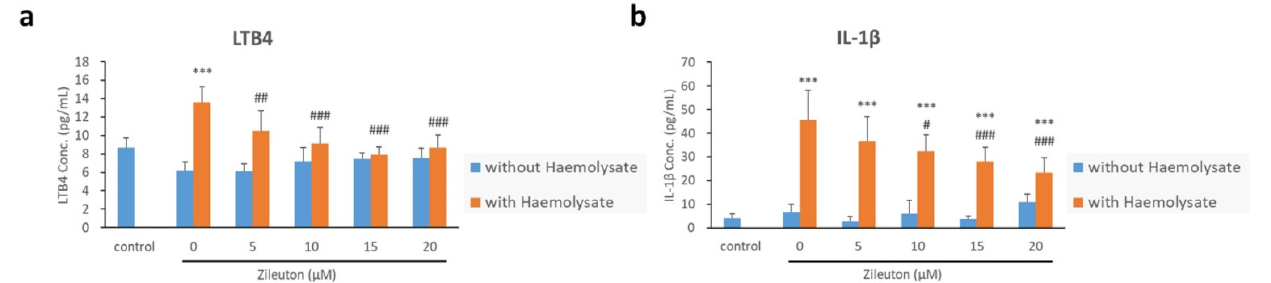
Figure 5. ELISA results for LTB4, IL-1 β , TNF- α , IL-10, and TGF- β from the cell culture superna- tant. ( a ) ELISA results for LTB4. The concentration of LTB4 in the haemolysate + vehicle group was higher than that in the control group. Following treatment with 5, 10, 15, and 20 μΜ of zileu- ton, the haemolysate-exposed BV-2 cells showed a lower concentration of LTB4 than those treated with the vehicle. There was no significant difference between haemolysate-exposed, zileu- ton-treated BV-2 cells, and BV-2 cells in the control group (*** p < 0.001 compared with control; ## p < 0.01, ### p < 0.001 compared with haemolysate + vehicle group, n = 3). ( b ) ELISA results for IL-1 β . The haemolysate + vehicle group and the haemolysate + zileuton (5, 10, 15, and 20 μΜ ) groups had a higher concentration of IL-1 β than the control group. The haemolysate-exposed BV-2 cells treated with 10, 15, and 20 μΜ of zileuton displayed a lower concentration of IL-1 β than BV-2 cells in the haemolysate + vehicle group (*** p < 0.001 compared with control; # p < 0.05, ### p < 0.001 compared with haemolysate + vehicle group, n = 3). ( c ) ELISA results for TNF- α . The haemolysate-exposed BV-2 cells treated with the vehicle, as well as 5, 10, 15, and 20 μΜ of zileuton, showed elevated concentrations of TNF- α compared with the control group. The haemolysate-exposed BV-2 cells treated with 15 and 20 μΜ of zileuton showed a lower concentration of TNF- α than those treated with the vehicle (*** p < 0.001 compared with control; ### p < 0.001 compared with haemolysate + vehicle group, n = 3). ( d ) ELISA results for IL-10. The haemolysate-exposed BV-2 cells treated with the vehicle, as well as 5, 10, 15, and 20 μΜ of zileuton, had an increased concentration of IL-10 compared with the control group. After being treated with 10, 15, and 20 μΜ of zileuton, haemol- ysate-exposed BV-2 cells showed a higher concentration of IL-10 than those treated with the vehicle (*** p < 0.001 compared with control; # p < 0.05, ## p < 0.01, ### p < 0.001 compared with haemolysate + vehicle group, n = 3). ( e ) ELISA results for TGF- β . The haemolysate-exposed BV-2 cells treated with the vehicle, as well as 5, 10, 15, and 20 μΜ of zileuton, showed an elevated concentration of TGF- β compared with the control group. Additionally, the concentration of TGF- β was higher in the haemolysate-exposed BV-2 cells treated with 10, 15, and 20 of zileuton than in those treated with the vehicle (*** p < 0.001 compared with control; ### p < 0.001 compared with haemolysate + vehicle group, n = 3).